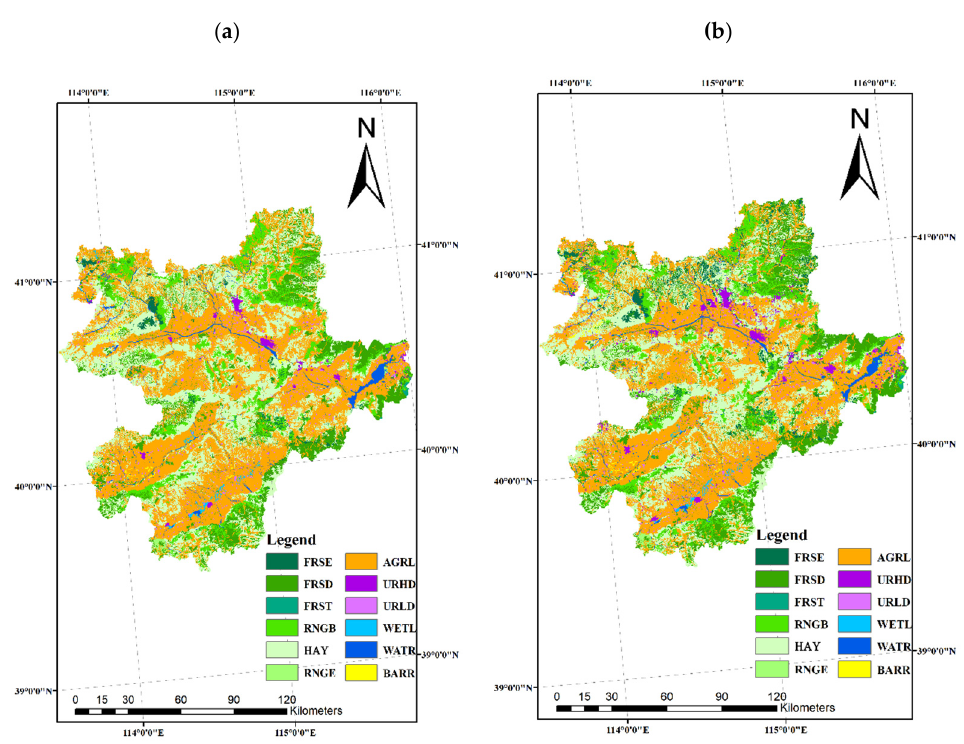
Figure 2. DEM and distribution of soil types in the study area in 2016.